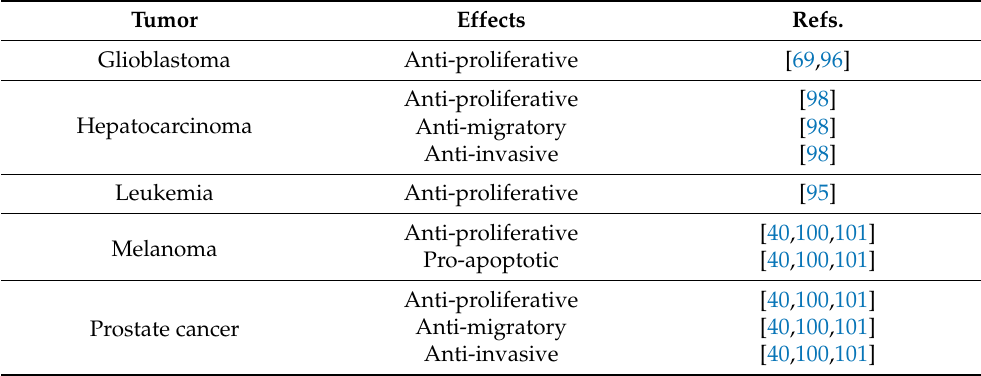
Table 2. HSPB8 anti-tumoral